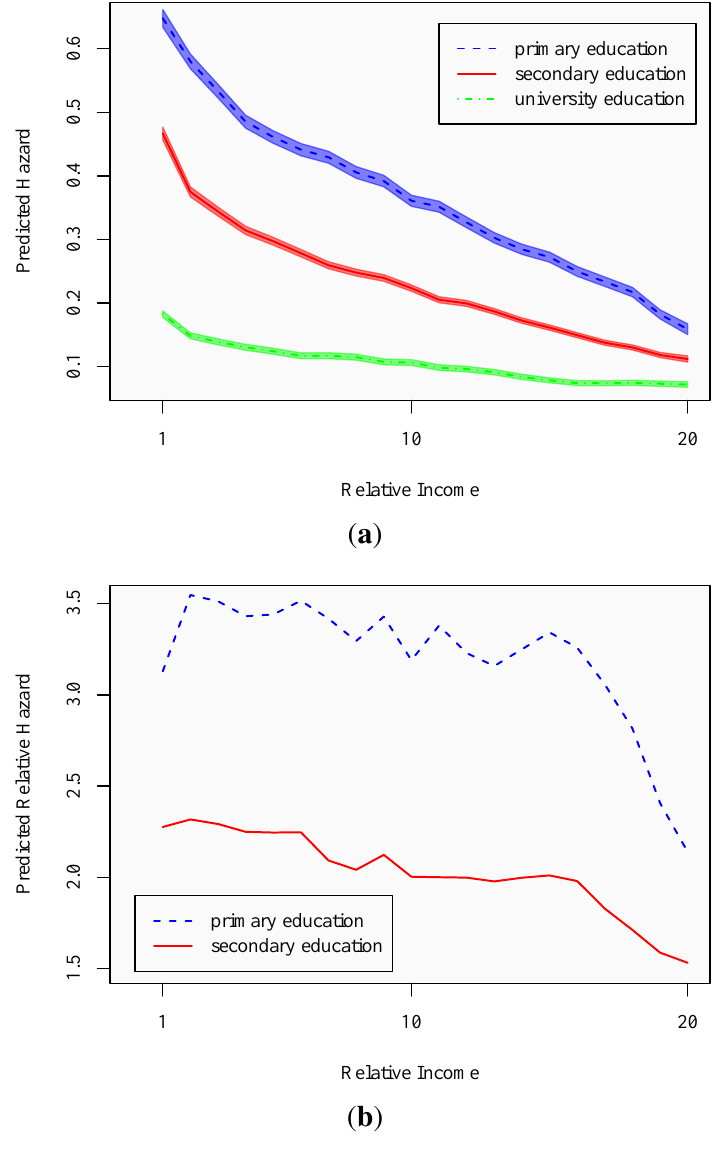
Figure 5. The effect of relative income and education on the sickness absence hazard. ( a ) Relative income and absolute hazard; ( b ) relative income and relative